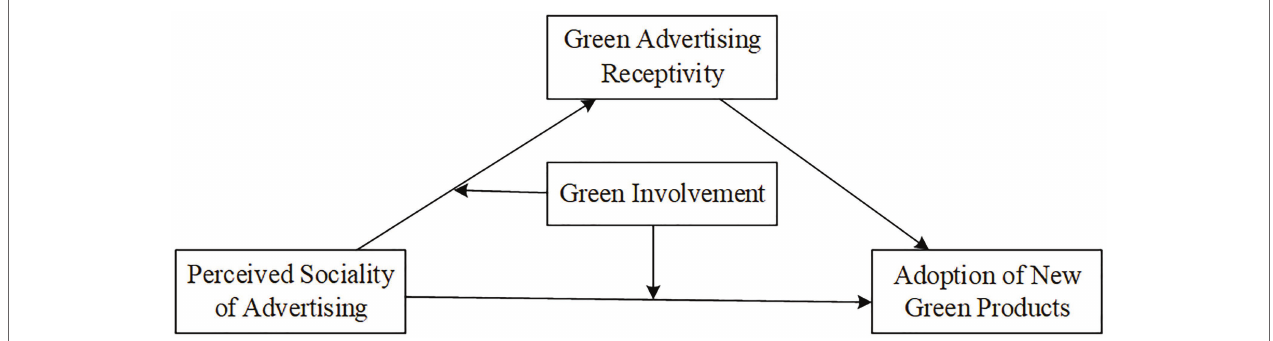
FIGURE 1 | Conceptual